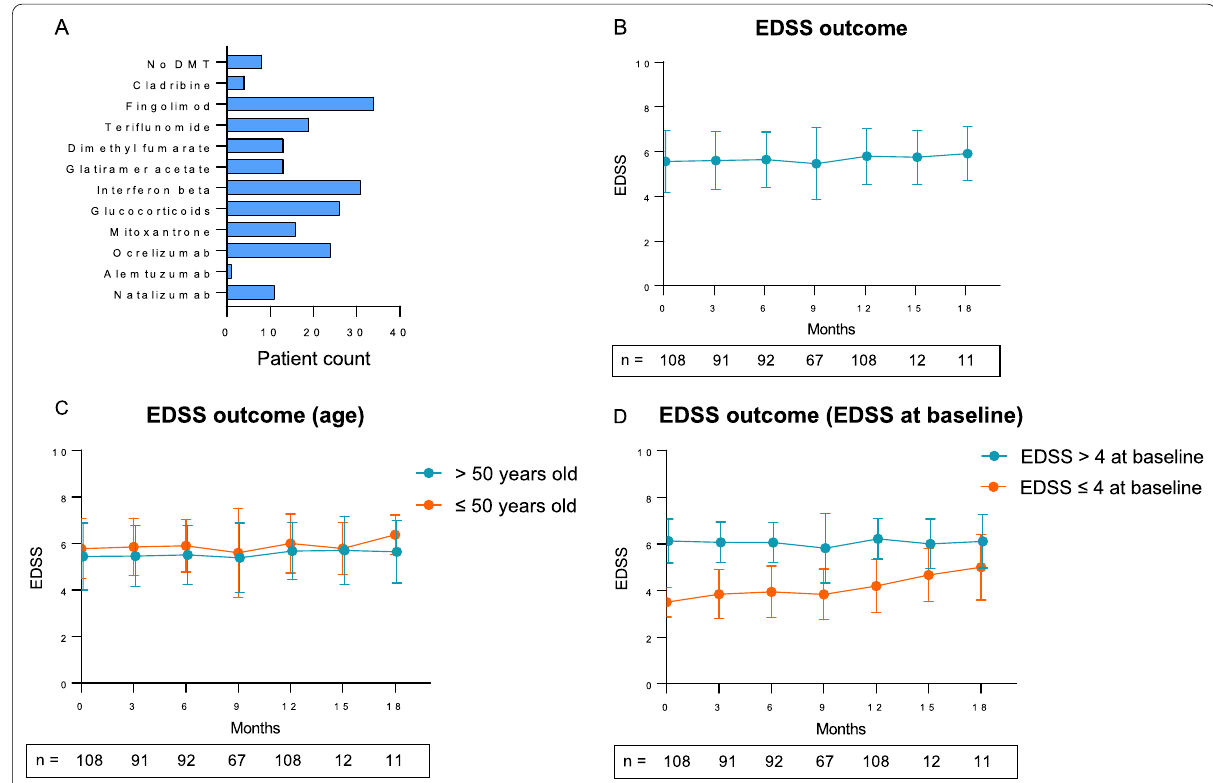
Fig. 2 Patient characteristics and EDSS outcome. Part A demonstrates the number of previous DMTs per patient prior to siponimod treatment. Part B shows the number of patients at each point in follow‑up and the corresponding mean EDSS at that time. Part C demonstrates the cohort divided into age above and below 50 and associated EDSS over time, with the number of patients at each time point of follow up given. Part D displays the EDSS over time with patient number at each follow‑up point included, with the cohort divided into EDSS Status